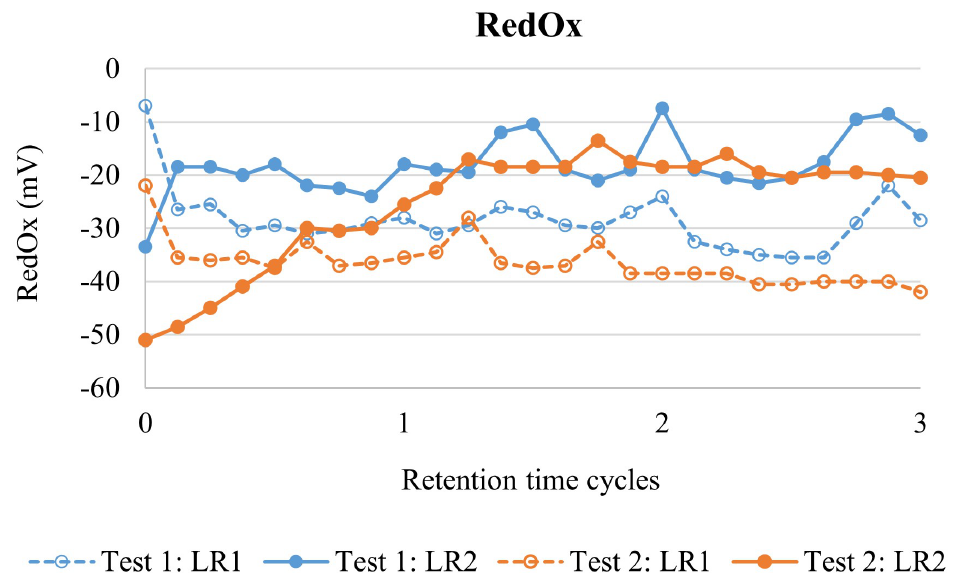
Figure 3. RedOx (mV) in the continuous mode tests. LR1 = the first leaching reactor, LR2 = the second leaching reactor.